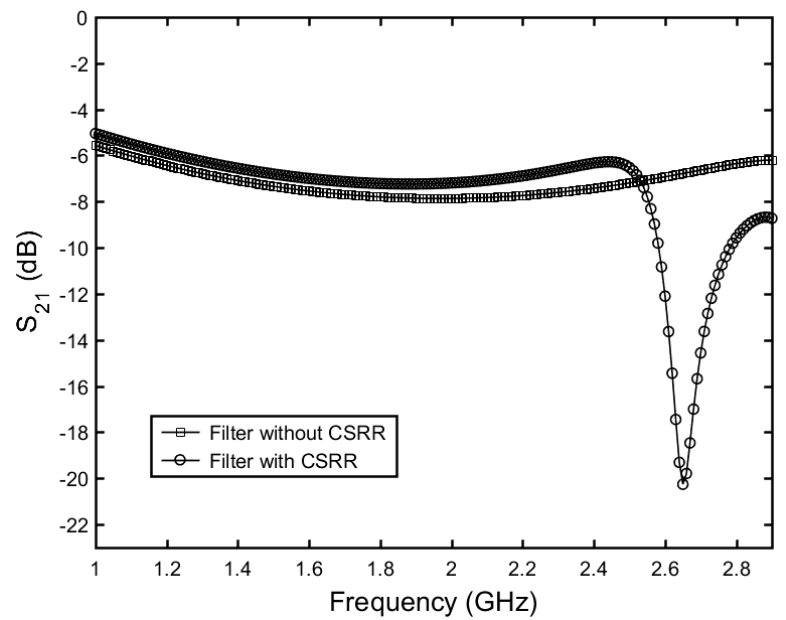
Figure 5. Simulated results of the transmission coefficient (S 21 ) for three different CSRR element positions on the microstrip planar circuit patch.